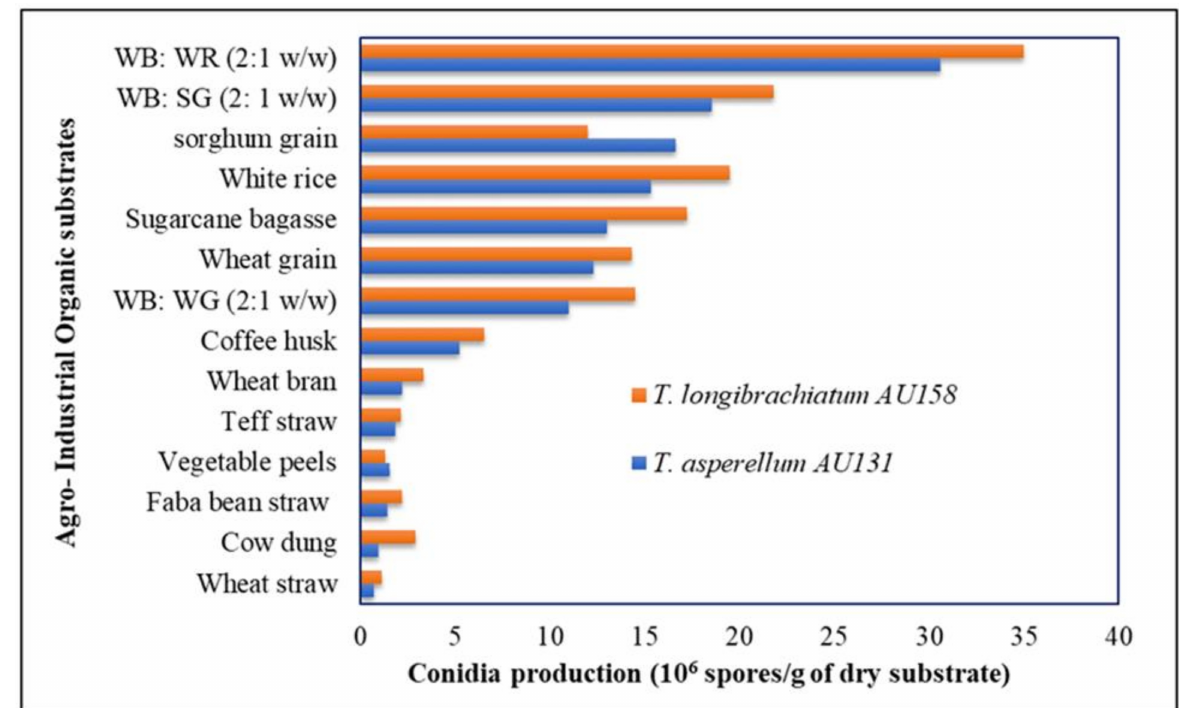
Figure 1. Spore production of Trichoderma species on different agro-industrial wastes and cereals after 21 days of incubation at 25 ± 2 ◦ C (WB = wheat bran, WR = white rice, SG = sorghum grain and WG = wheat grain).